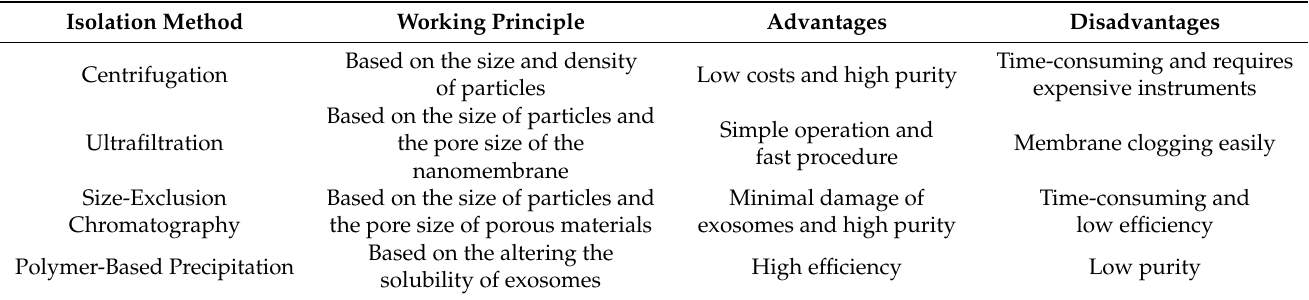
Table 1. Conventional isolation method for